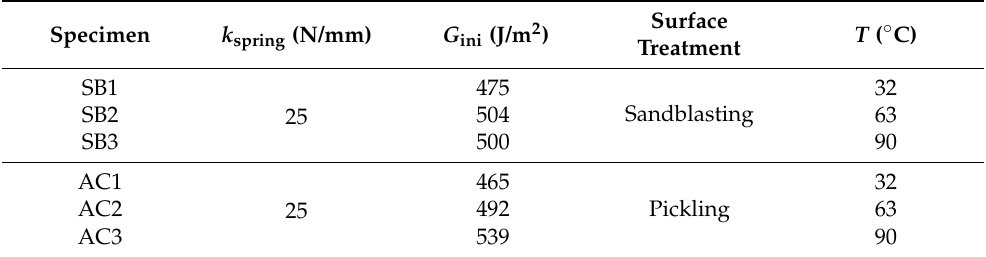
Table 2. Experimental conditions for studying the effects of the surface treatment and immersion tem-